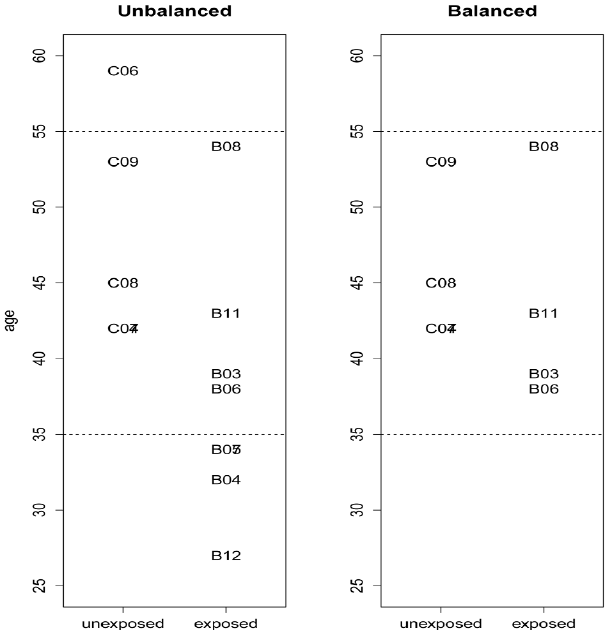
Figure 2. Distribution of age for the complete and age-balanced dataset. Benzene exposed (B), and